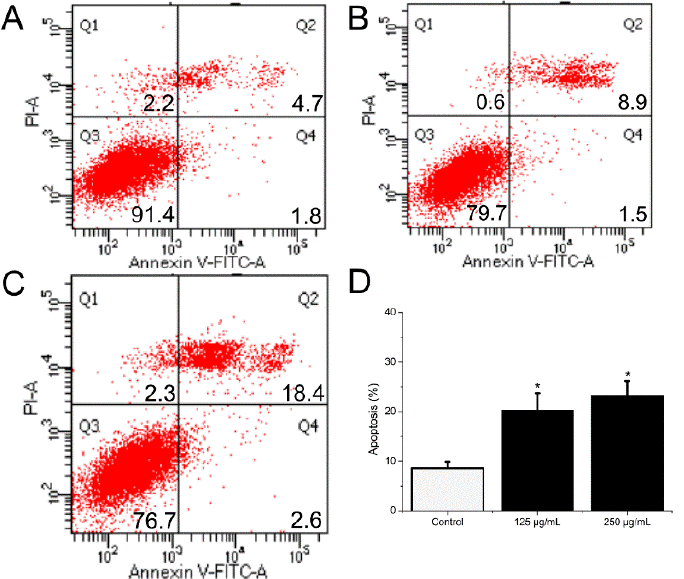
Figure 5. The influence of BSO on HCT116 cell apoptosis. Cells were collected after treatment and then stained with antibodies to annexin V and propidium iodide. After that, flow cytometry proceeded. BSO (125, 250 μ g/mL) significantly promoted cell apoptotic. ( A – C ) Dot plot stained with annexin V and propidium iodide. ( D ) The percentages of apoptotic cells. As ± 3 replicate experiments were performed and the results were demonstrated in the form of means ± SD. * p < 0.05 versus control; * p < 0.05, versus negative control group. Q1, dead cells; Q2, dead/late apoptotic cells; Q3, normal cells;Q4, early apoptotic cells; Q2 + Q4, total apoptotic cells.